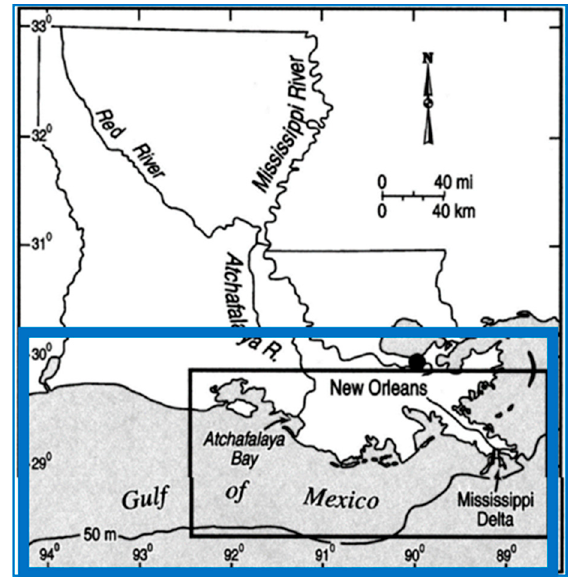
Figure 1. Map showing the Mississippi-Atchafalaya River Basin (MARB) from a Google map with line color modification.